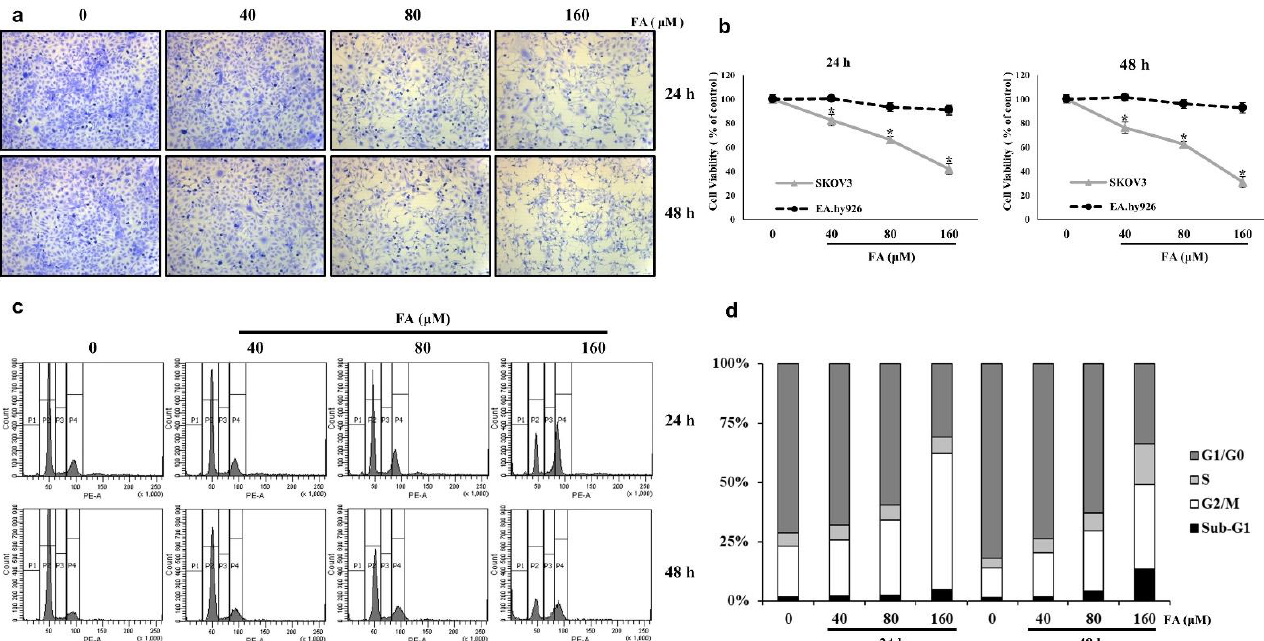
Figure 2. Farrerol (FA) inhibits cell proliferation of SKOV3 cells through G2/M cell cycle arrest. ( a ) Crystal violet-stained cell images of SKOV3 cells after treatment with the indicated concentration of FA for 24 and 48 h. ( b ) The cell viability of SKOV3 and EA.hy926 on FA treatment cells was measured via an MTT assay. Data are means ± standard deviation from three independent experiments (*, p < 0.05). ( c ) SKOV3 cells were treated with FA (0, 40, 80, or 160 μM) for 24 or 48 h, harvested, and digested with RNase. Cellular DNA was stained with propidium iodide, and the cell cycle distribution was analyzed using flow cytometry. ( d ) Cell cycle distribution data.